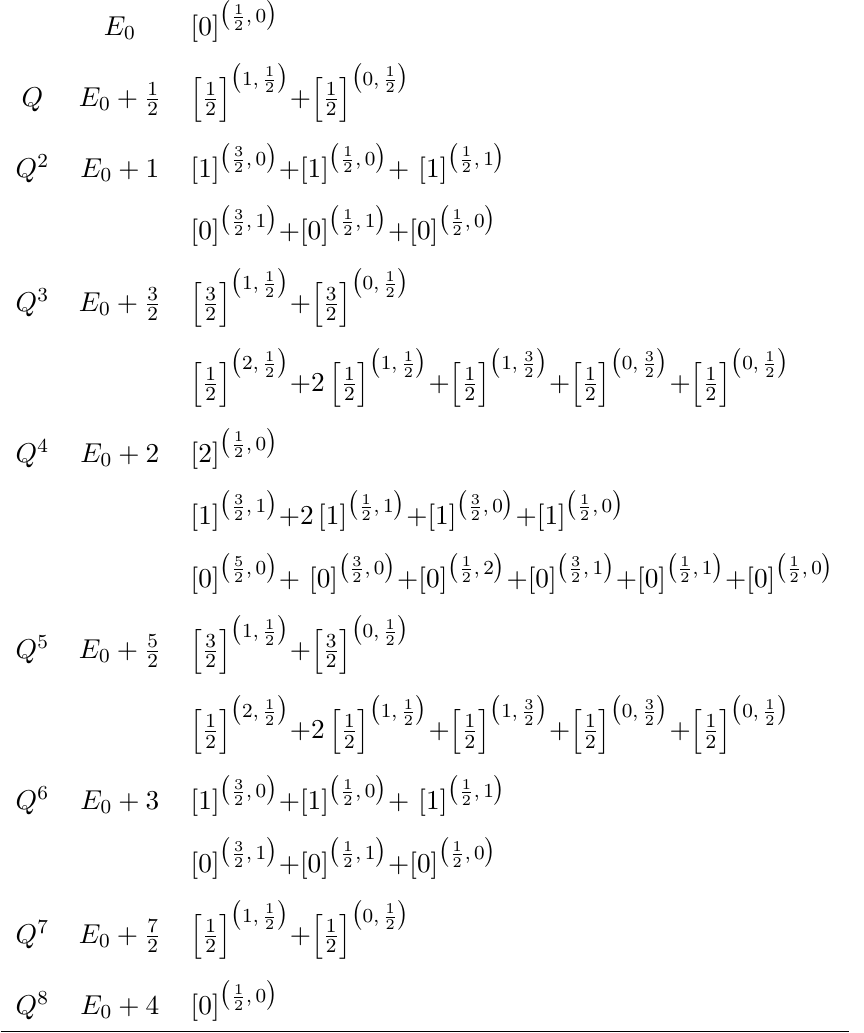
Table 4 . States in the long graviton supermultiplet LGRAV 4 tected multiplets in table 1. The short flavoured multiplets appear accidentally in the spectra of the SO(4) and SU (2) points, joining other multiplets into SO(4) and SU (2) F representations. An extreme case of the shortening conditions occurs when the graviton becomes massless. In this case, we have the following splitting of a massless N = 4 graviton multiplet into N = 2 massless